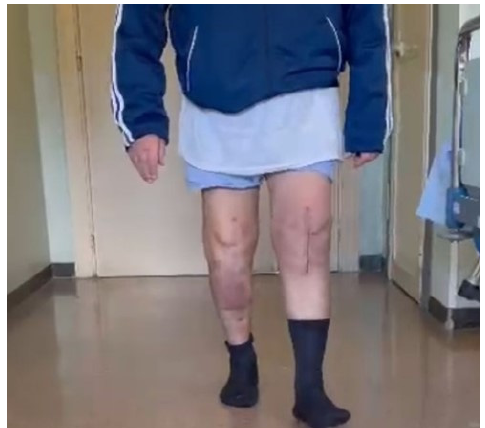
Figure 1. Patient’s condition two months after